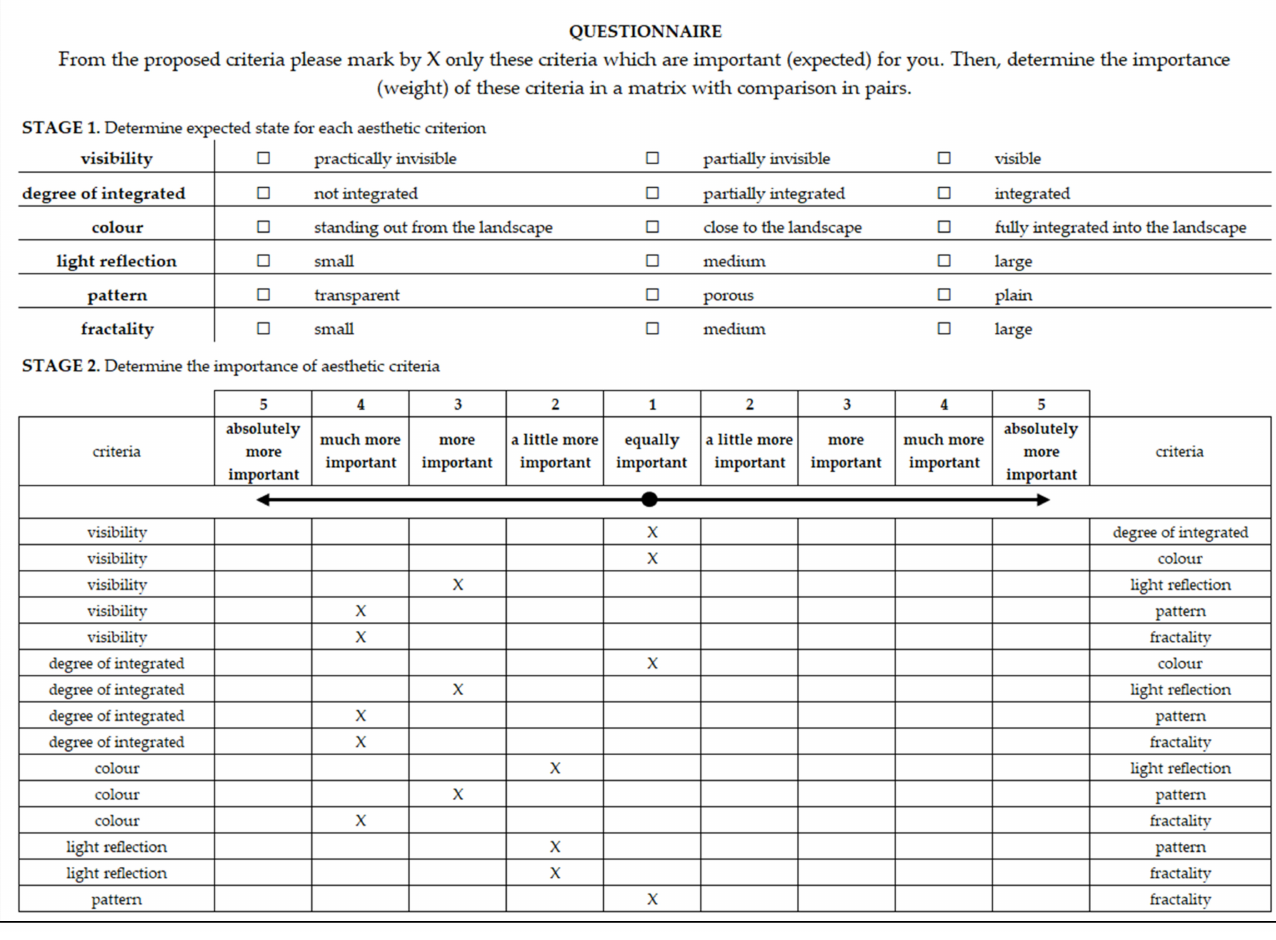
Figure 10. Results of questionnaire for customer expectations for aesthetic criteria of PV. Own